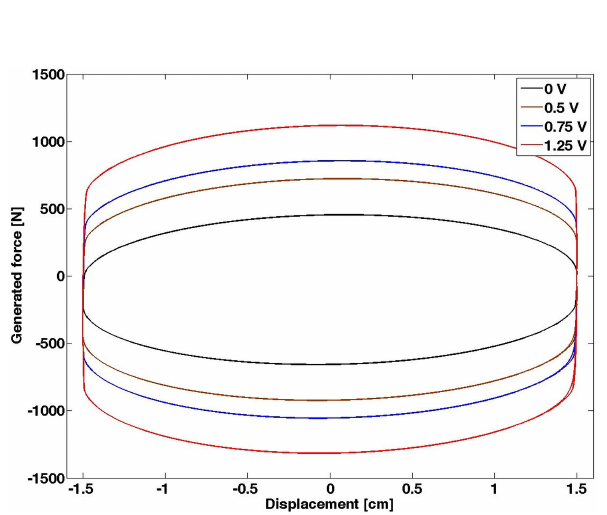
Figure 5. Force–velocity hysteresis loop of the simulated Bouc– Wen model under sinusoidal excitation.